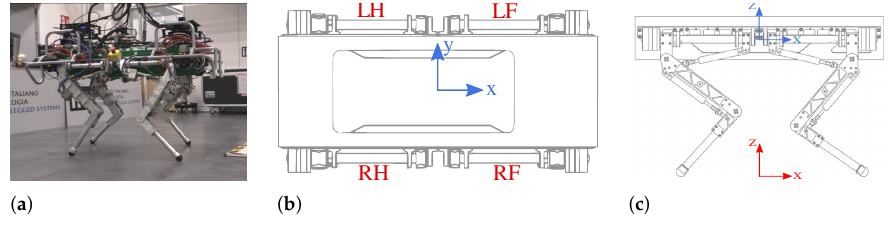
Figure 1. ( a ) HyQ robot, ( b , c ): location of robot base frame (blue) and world frame (red). LF, RF, LH, and RH are the Left-Front, Right-Front, Left-Hind, and Right-Hind legs,